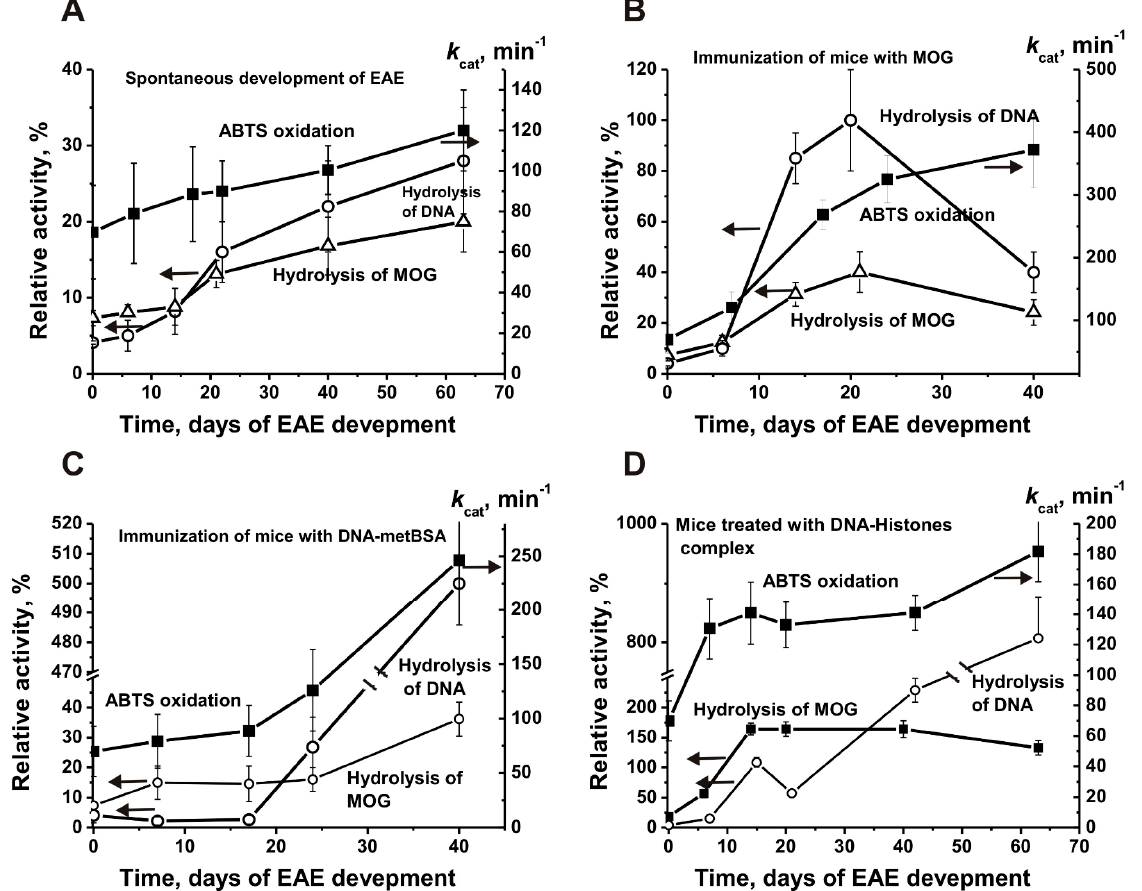
Figure 9. Over time changes in the relative activity of mice IgGs in the hydrolysis of MOG and DNA in the ( A – D ; left scales) as well as oxidation of ABTS ( k cat , min − 1 ; A – D ; right scales). The mean values of the activities of IgGs from seven mice during spontaneous ( A ) as well as accelerated development of EAE after immunization of mice with MOG ( B ), DNA–met–BSA ( C ), and DNA–histones ( D ) are given. All designations are marked in the panels: the arrows indicate to which Y -axis the given curve belongs—to the right or the left [194].